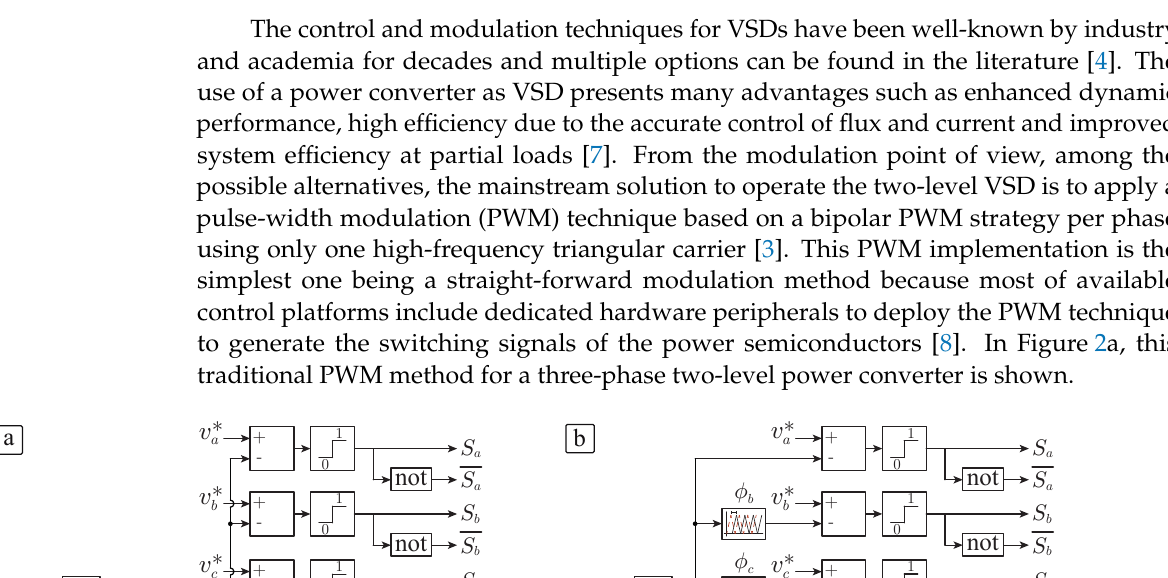
Figure 1. Traditional three-phase two-level converter for a motor drive application.